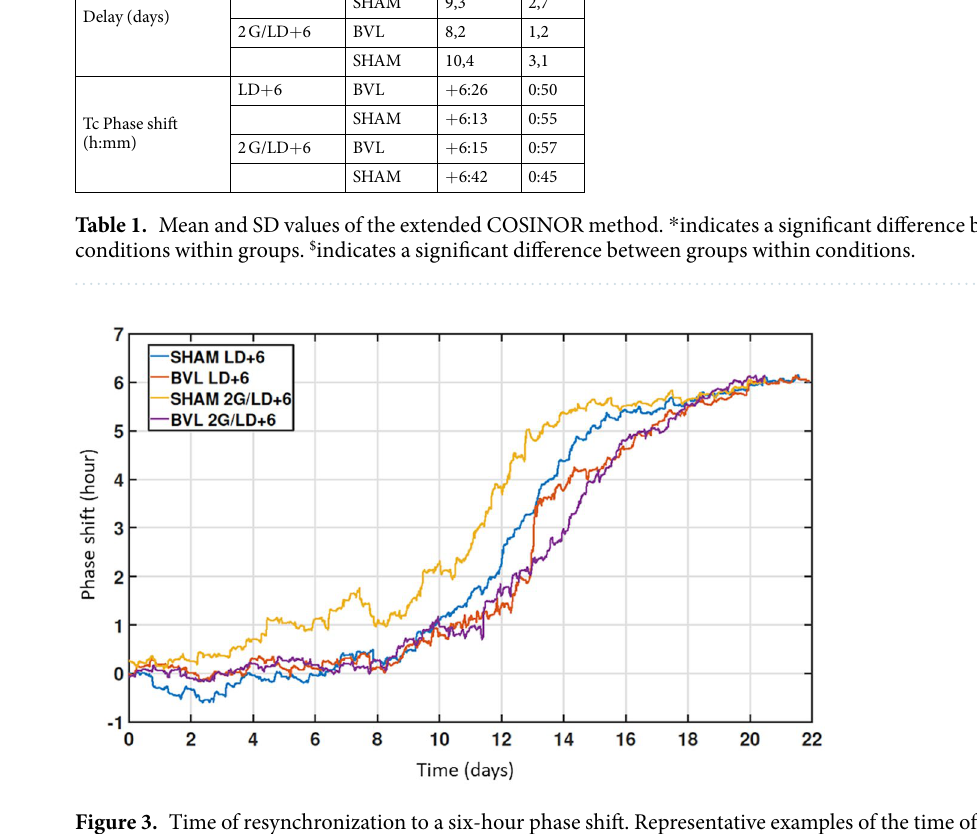
Figure 3. Time of resynchronization to a six-hour phase shift. Representative examples of the time of convergence of a BVL and a sham rat in both the LD + 6 and 2 G/LD + 6 conditions. Each line represents the progressive drifting of the phase to achieve resynchronization after the six-hour shift of the LD